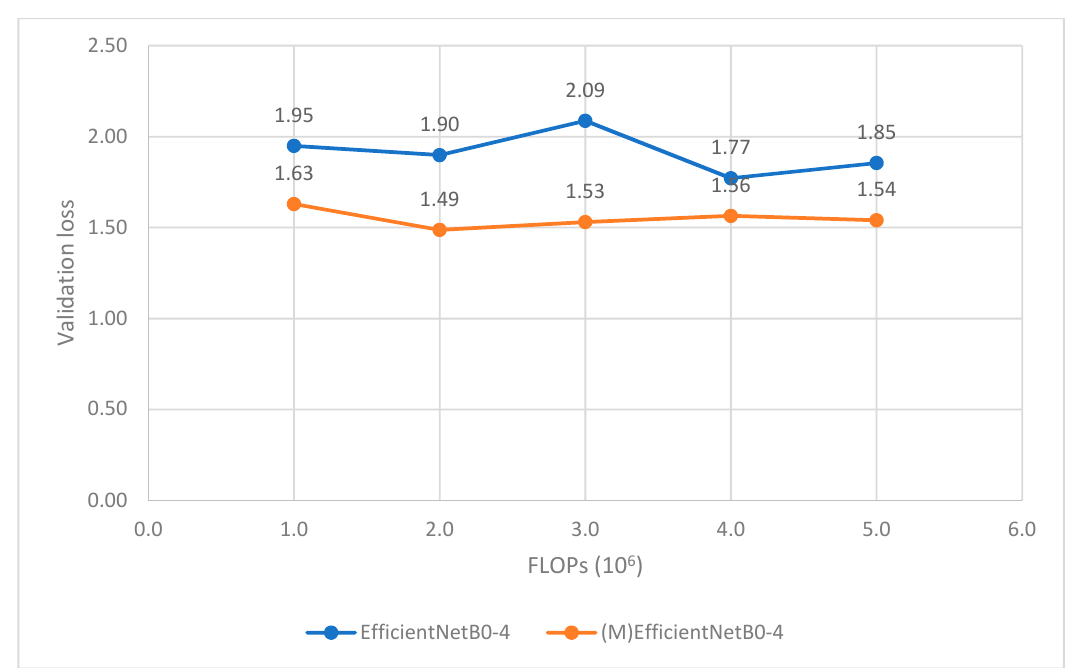
Figure 13. Comparison between EfficientNet and (M) EfficientNet (B0–B4, left to right, respectively).